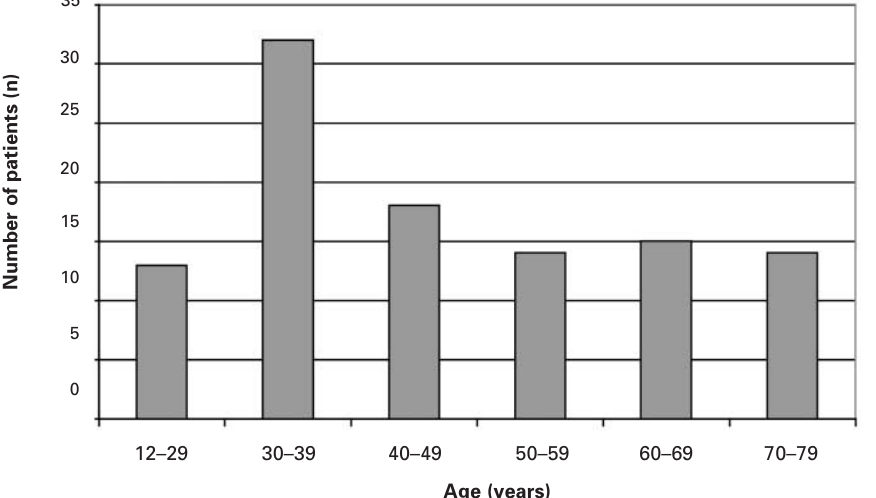
Figure 1 Age distribution in patients with